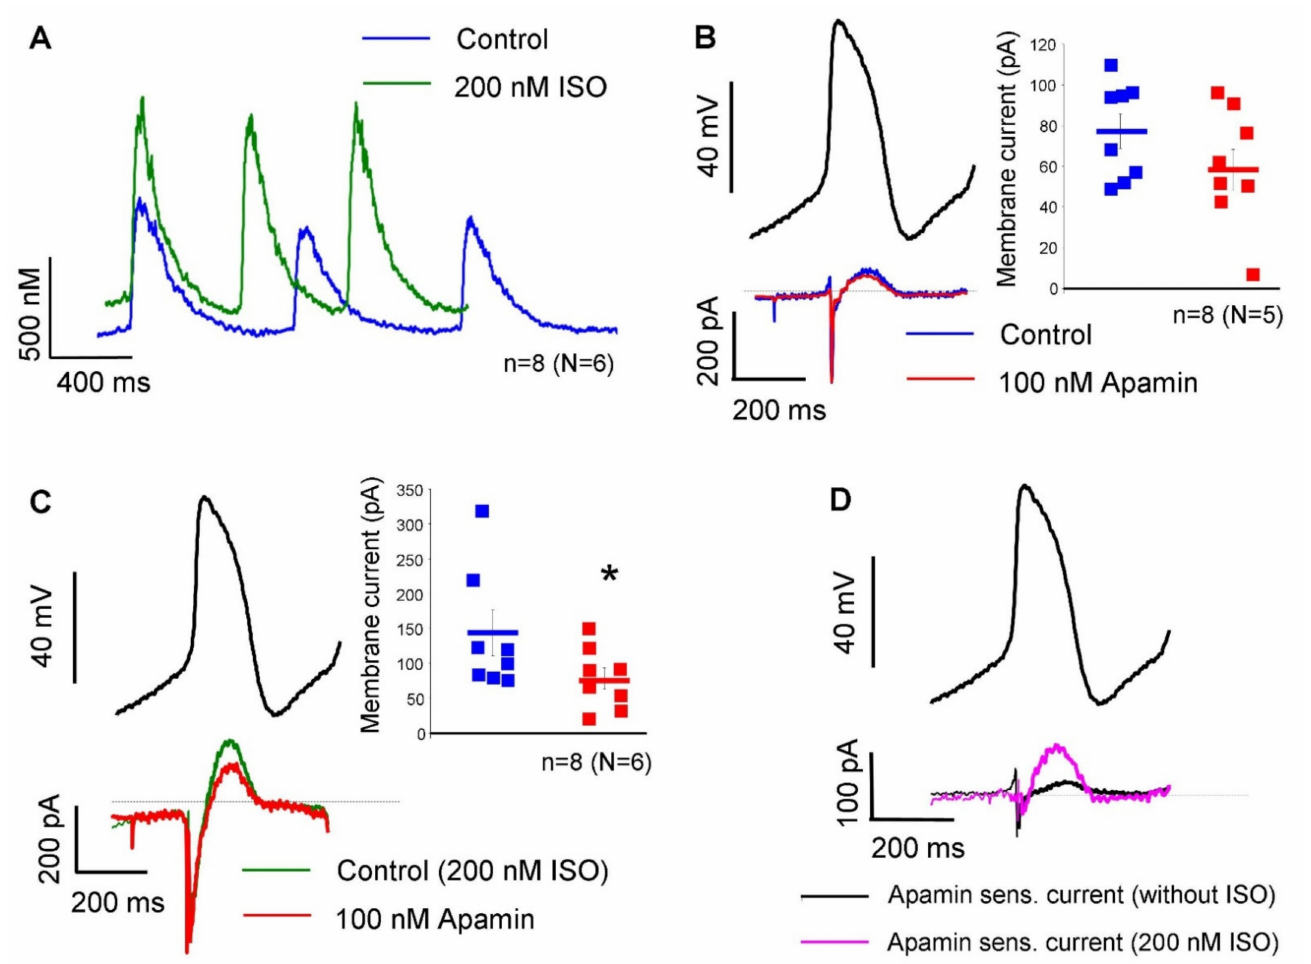
Figure 4. Measurement of apamin-sensitive current under a representative SAN action potential waveform in the absence and in the presence of 200 nM isoproterenol (ISO). ( A ) demonstrates the effect of 200 nM isoproterenol on Ca 2+ transients. When isoproterenol was omitted, 100 nM apamin (red curve) did not alter the peak of the total current (blue curve, panel ( B )). In the presence of 200 nM isoproterenol, 100 nM apamin (red curve) decreased the peak current (green curve, panel ( C )). Representative original traces were determined after subtraction of currents. When 200 nM isoproterenol was employed, the apamin-sensitive current (purple curve) was larger than under normal conditions (black curve, panel ( D )). Paired and unpaired t -tests ( p <